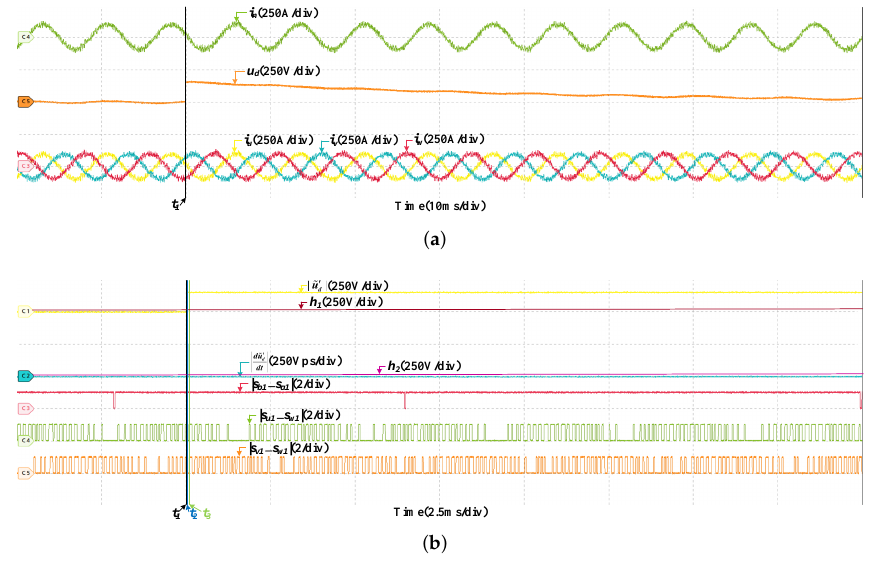
Figure 8. HIL results when the offset fault occurs in S Vd at 200 km/h. ( a ) The results of the grid current, DC-link voltage and stator currents. ( b ) The results of fault